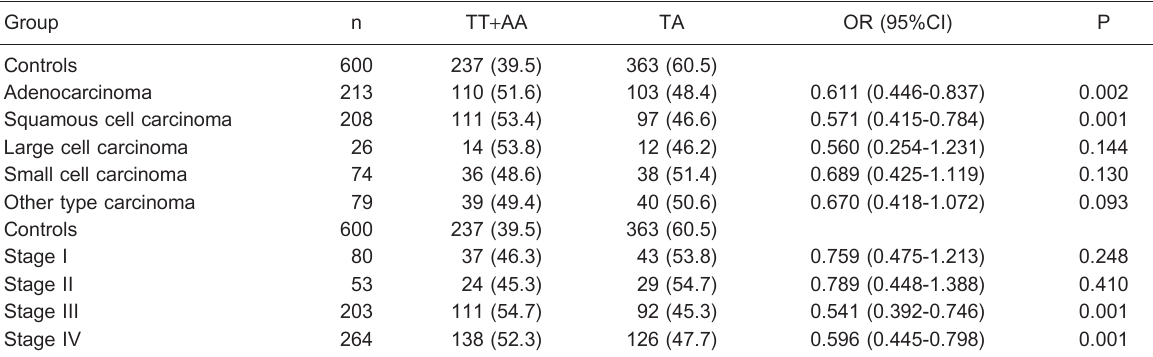
Table 4. Association between genotype frequency and type of pathology and clinical